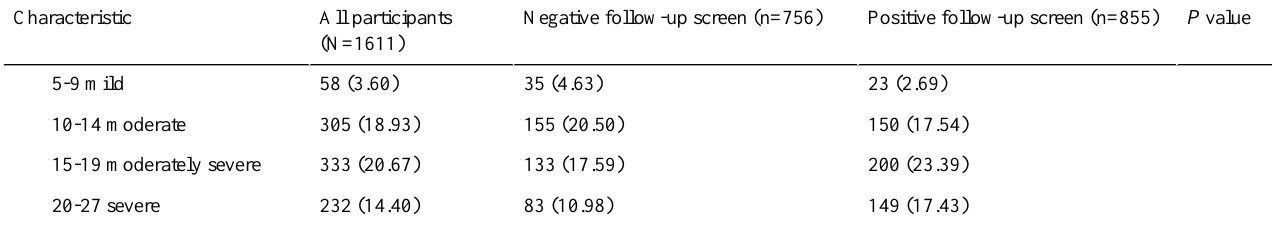
Table 3. Associations between care modality and improvement (n=1611).